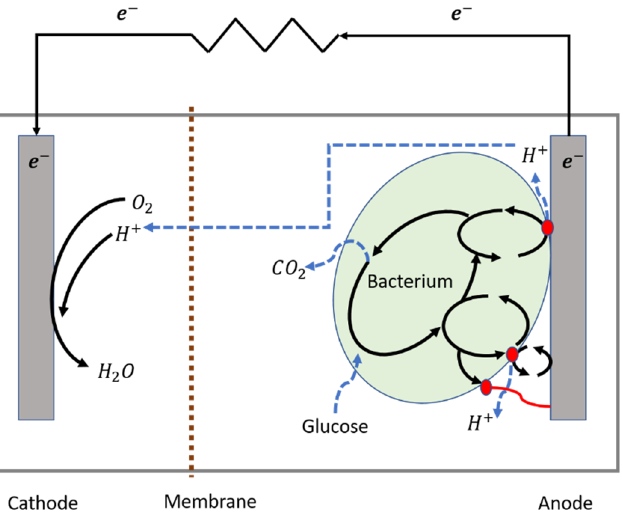
Figure 2. A classic dual chamber microbial fuel cell (MFC) with cathode, cation exchange membrane and anode (from left to right).